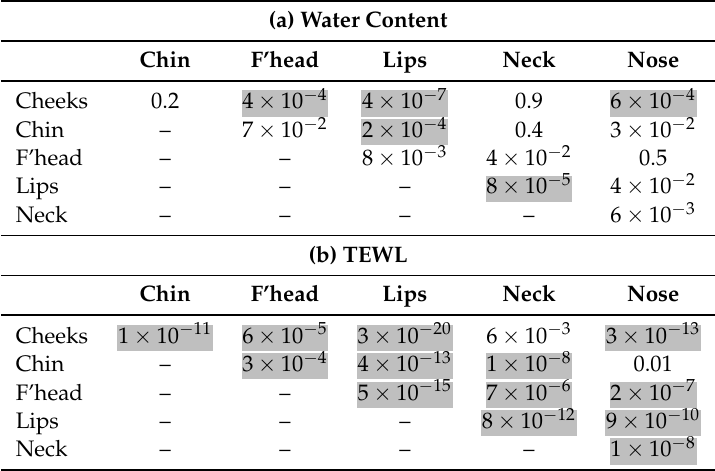
Table 2. Water content and TEWL: results of the pairwise comparisons ( p -value) between the six facial areas. Significant differences ( α ∗ = 3.3 × 10 − 3 ) are